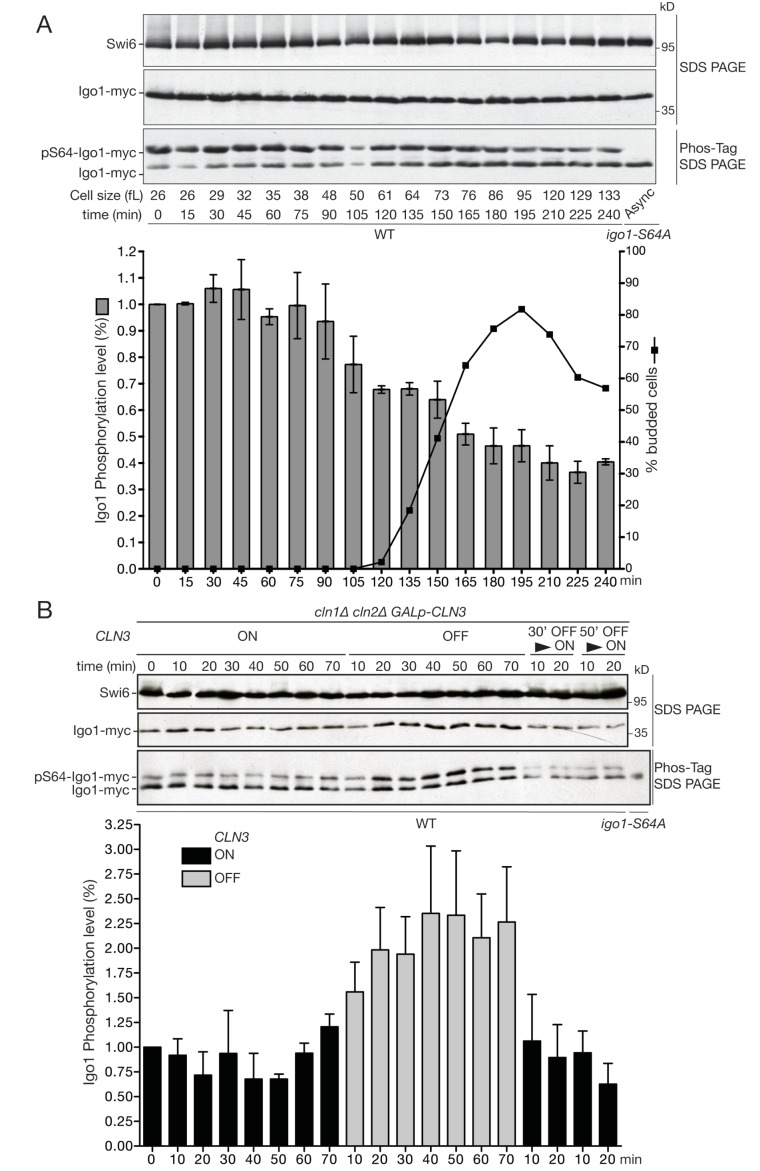
The Rim15 pathway is active in early G1 cells and negatively regulated by Cln3-Cdk1 kinase.(A) Western blot and quantification of the level of Igo1 phosphorylation (P-Igo1/total Igo1) during a synchronous cell cycle after elutriation of IGO1-myc cells (E4996). Mean (SD) of three experiments. Value was arbitrarily set at 1 for the first time point. (B) Igo1-S64 phosphorylation level in exponentially growing cln1∆ cln2∆ cln3::GAL-CLN3 cells (E5261) shifted from SC-Gal to SC-D for the indicated time, filtered after 30 or 50 min and put back in SC-Gal for 10 and 20 min. Quantification of phospho-S64-Igo1 shows the mean (SD) of three experiments. Value was arbitrarily set at 1 for the first time point.